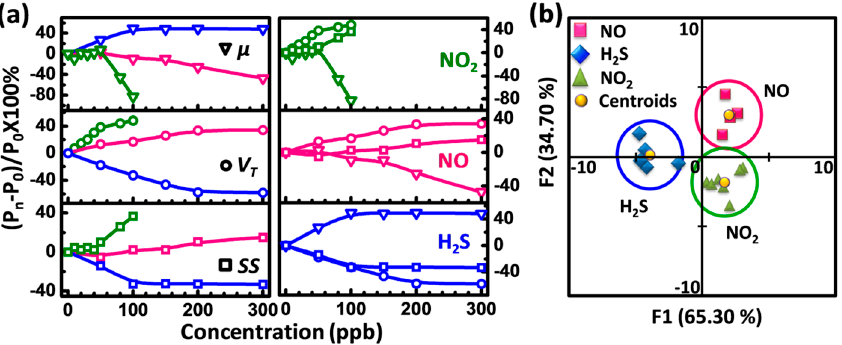
Figure 5. ( a ) percentage variation of a certain parameter at different gas concentrations ( left panel), and percentage variation of different parameters for a certain gas at different gas concentrations ( right panel). μ : , V T : ○ , SS : □ ; NO 2 : green ; NO: pink , H 2 S: blue ; ( b ) the results of the LDA analysis of the multiple parameters ( μ , V T , SS and I on ) obtained from the single nanobelt device. The LDA analysis classified and separated the points corresponding to the different gases in dynamic concentration at a 95% confidence level.